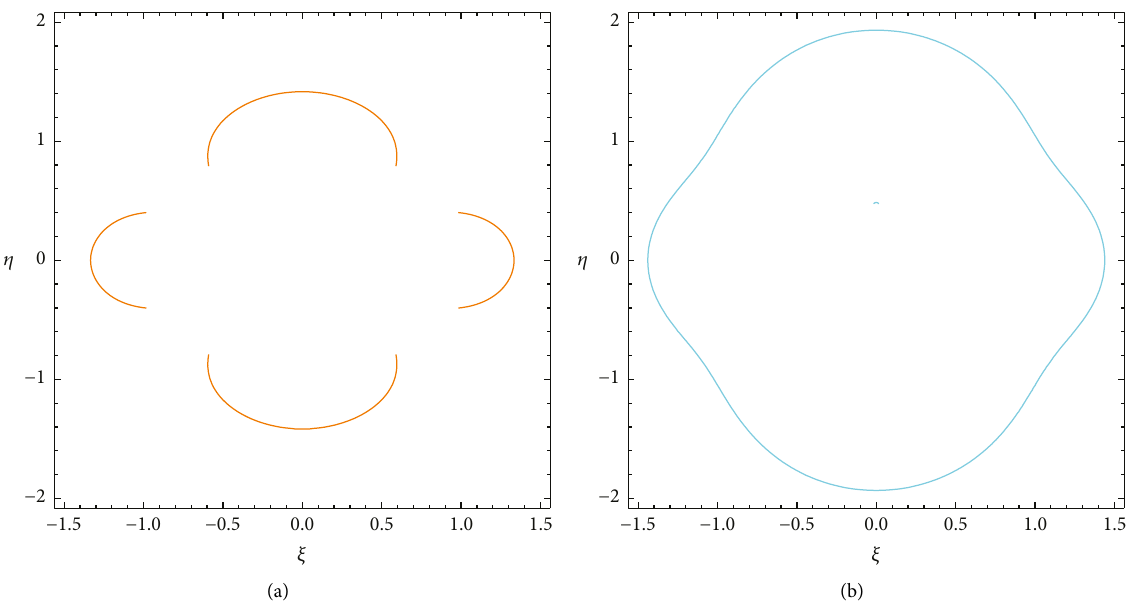
Figure 14: Condition (ii): projection of stability regions (a) b � 0 . 67 and a � 0 . 78; (b) b � 0 . 80 and a � 0 .